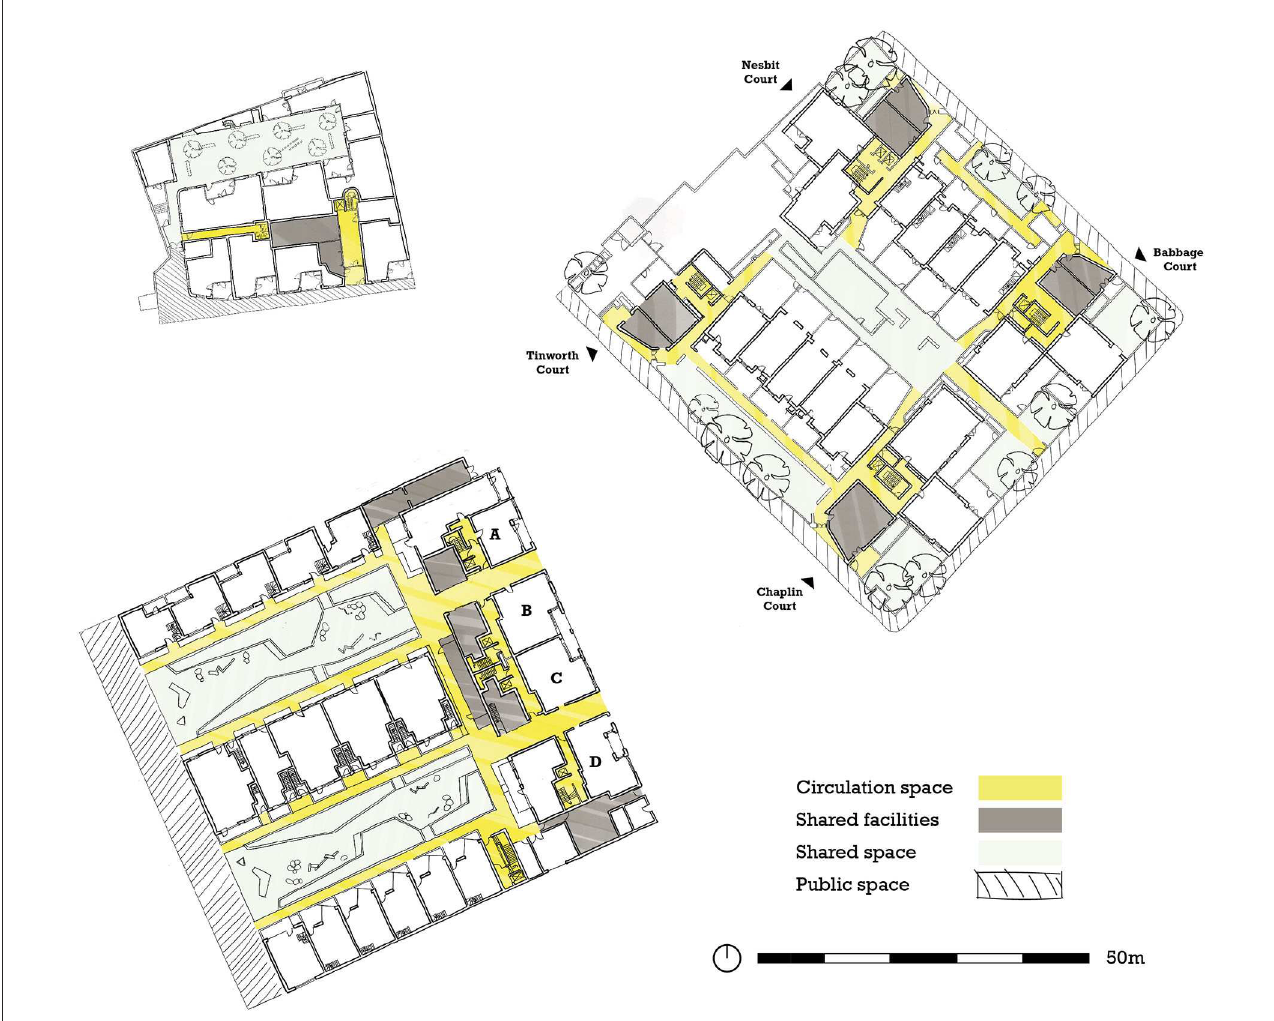
FIGURE13 Cross-case ground floor plan comparison (to